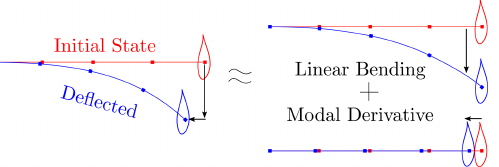
Figure 4. Bending deflection of a straight beam in the first mode shape and its representation by linear mode shape and its modal